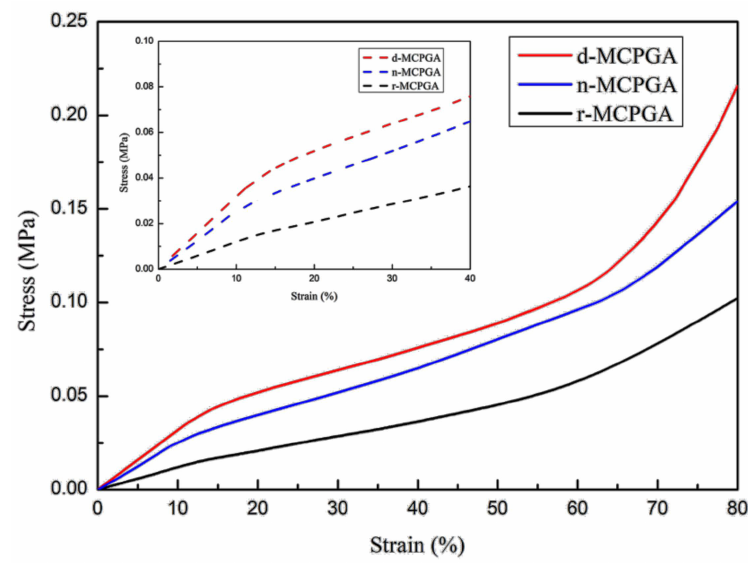
Figure 6. Compressive behavior of aerogels (d-MCPGA, r-MCPGA, n-MCPGA) prepared by di ff erent freeze-drying methods consisting of CNFs, PVA and GO.